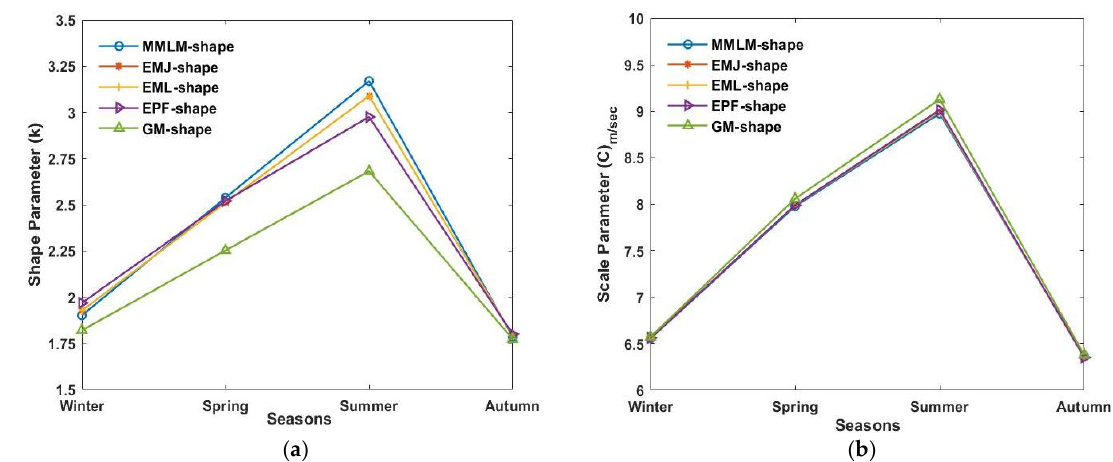
Figure 14. Seasonal average values of ( a ) the shape ( k ) and ( b ) scale ( c ) parameters calculated using the MMLM, EMJ, EML, EPF and GM methods.